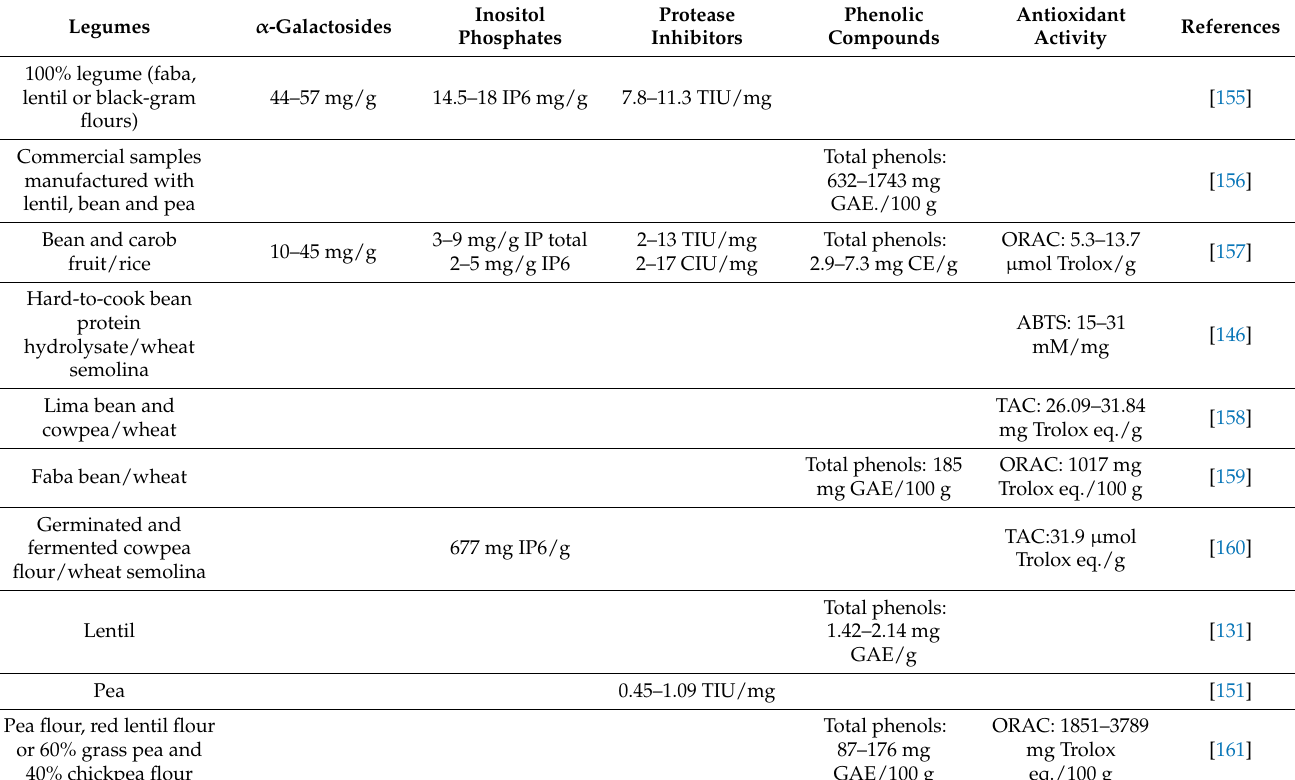
Table 4. Content of different bioactive compounds ( α -galactosides, inositol phosphates, protease inhibitors, phenolic compounds and antioxidant activity) in uncooked legume-based pasta.